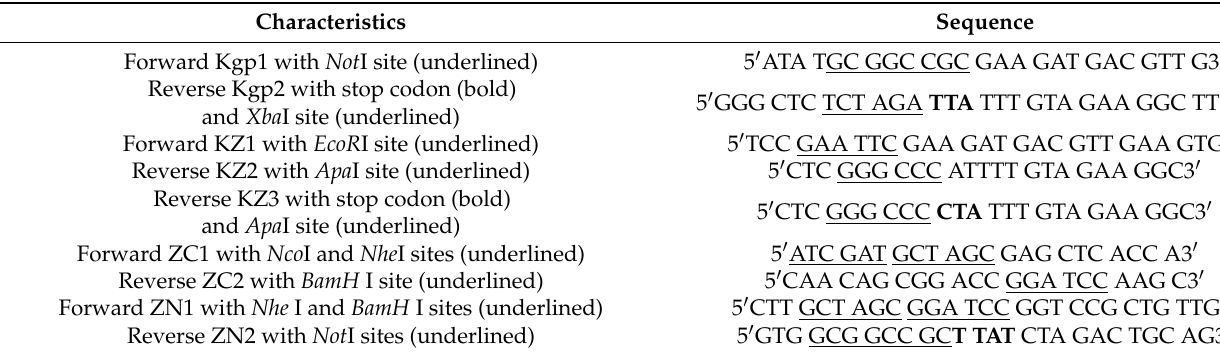
Table 1. List and sequence of the